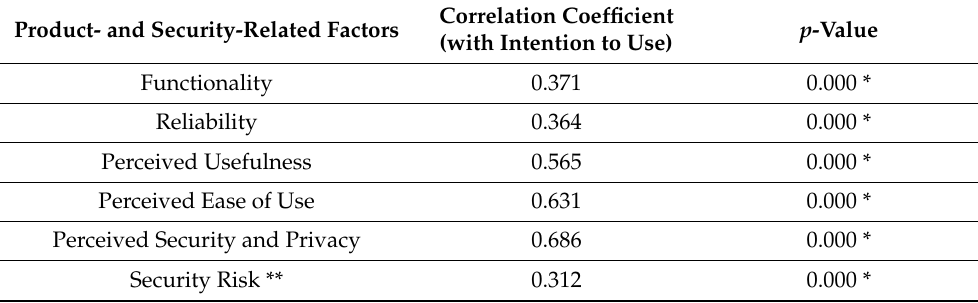
Table 11. Correlation between product- and security-related factors and intention to